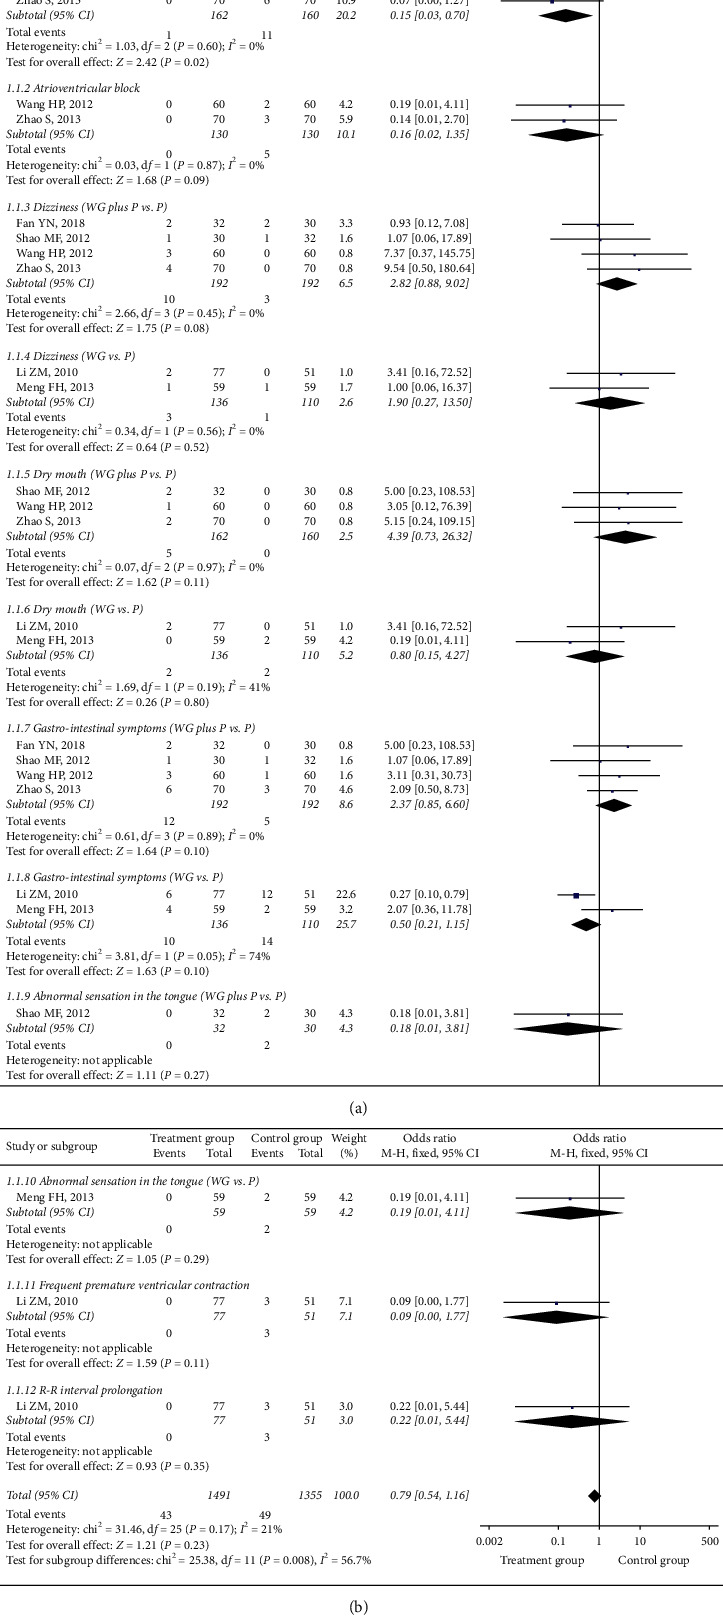
The forest plot of outcome measure adverse reactions.